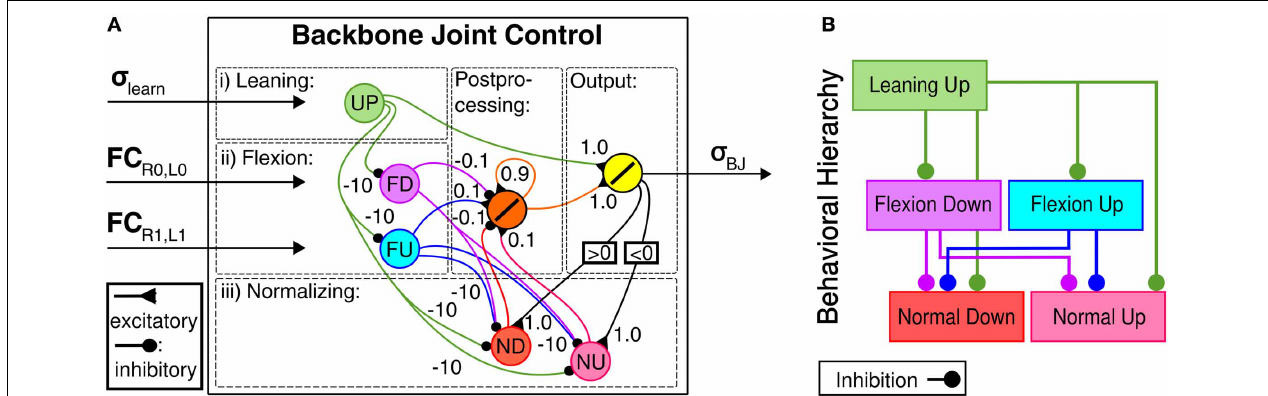
FIGURE 5 | Backbone Joint Control (BJC). (A) Neural module for BJC. It receives preprocessed sensory input signals from ultrasonic (US) and foot contact (FC) sensor. Five input neurons are connected to an output neuron